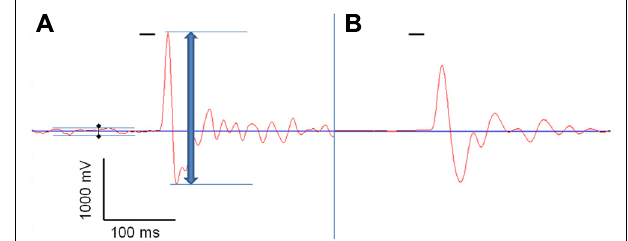
FIGURE 1 |Acoustic startle response measurement. One acoustic startle response, measured by the Med Associates startle box, of a BK knock-out mouse (BK α − / − , A ), and of a wild-type animal (WT, B ), both recorded with a transducer signal gain of 1.The red line shows the voltage signal produced by the transducer that reflects the vertical dislocation of the platform by the animals’ movement, and the short horizontal black bar represents the startle stimulus.The blue arrow indicates the peak-to-peak amplitude measured by the system.The black diamonds indicate the baseline noise generated by the knock-out mouse’s tremor that was subtracted from the total startle